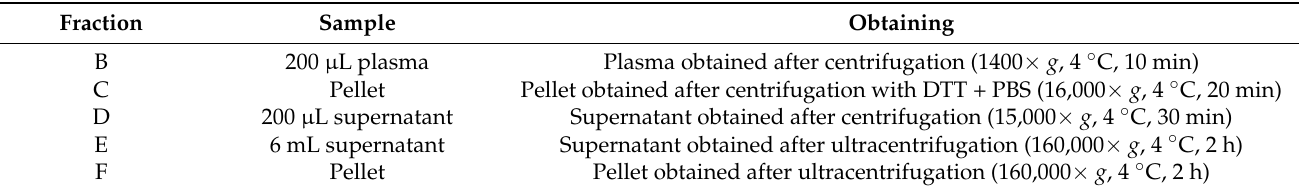
Table 2. Fractions obtained during exosomes